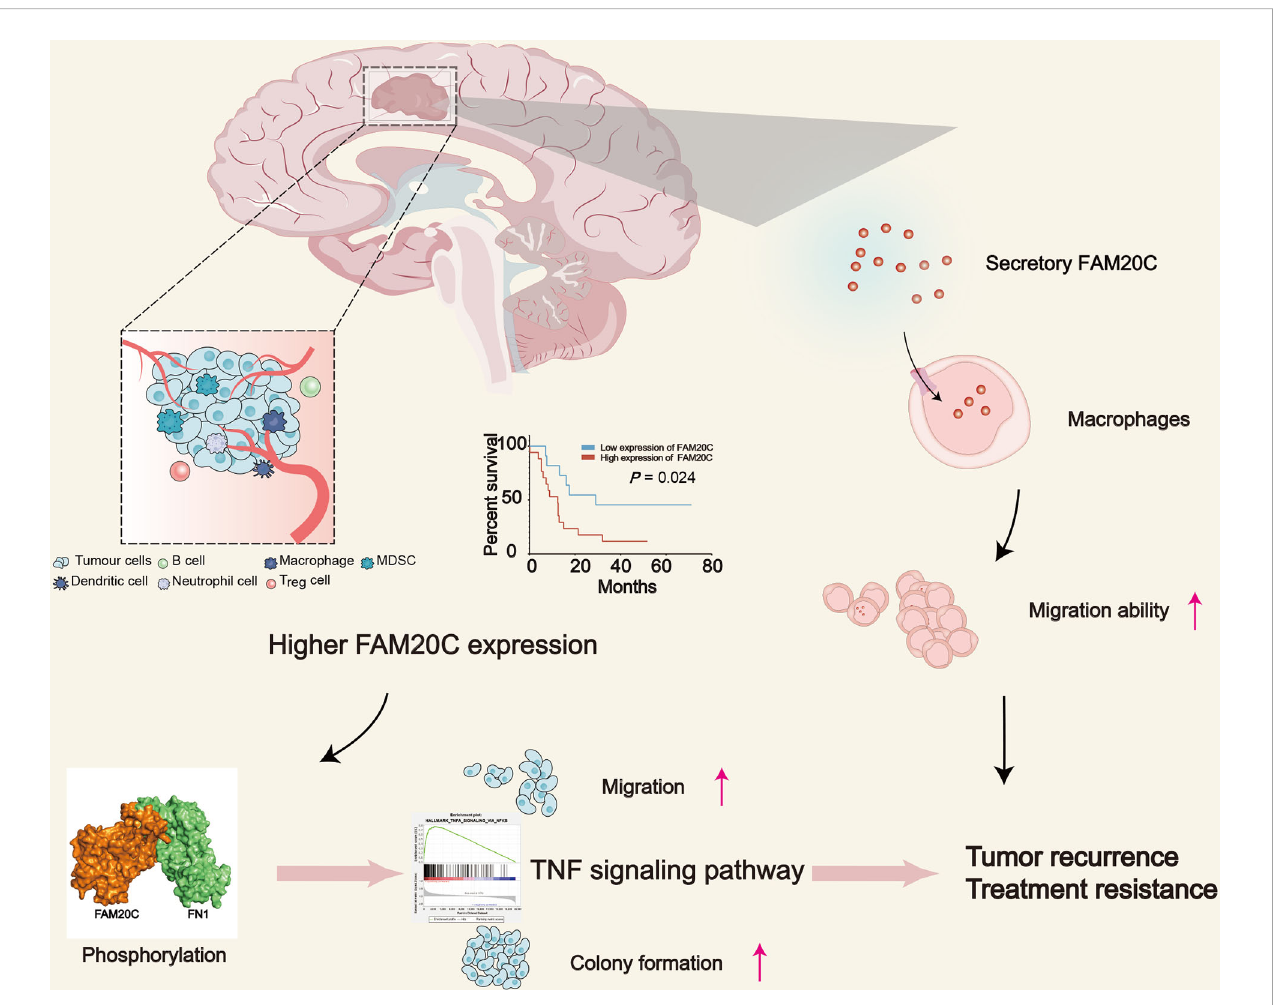
FIGURE 3 The schematic diagram depicts the role of FAM20C in promoting GBM progression. GBM with high FAM20C expression is associated with poor prognosis, and FAM20C promotes the migration and clone formation of tumor cells by binding with FN1 and activating the TNF signaling pathway. Also, FAM20C secreted by tumor cells promotes the migration of tumor-associated macrophages, which plays an important role in the development of tumors, modulation of neoangiogenesis, immune suppression, and metastasis. This may lead to tumor recurrence and treatment